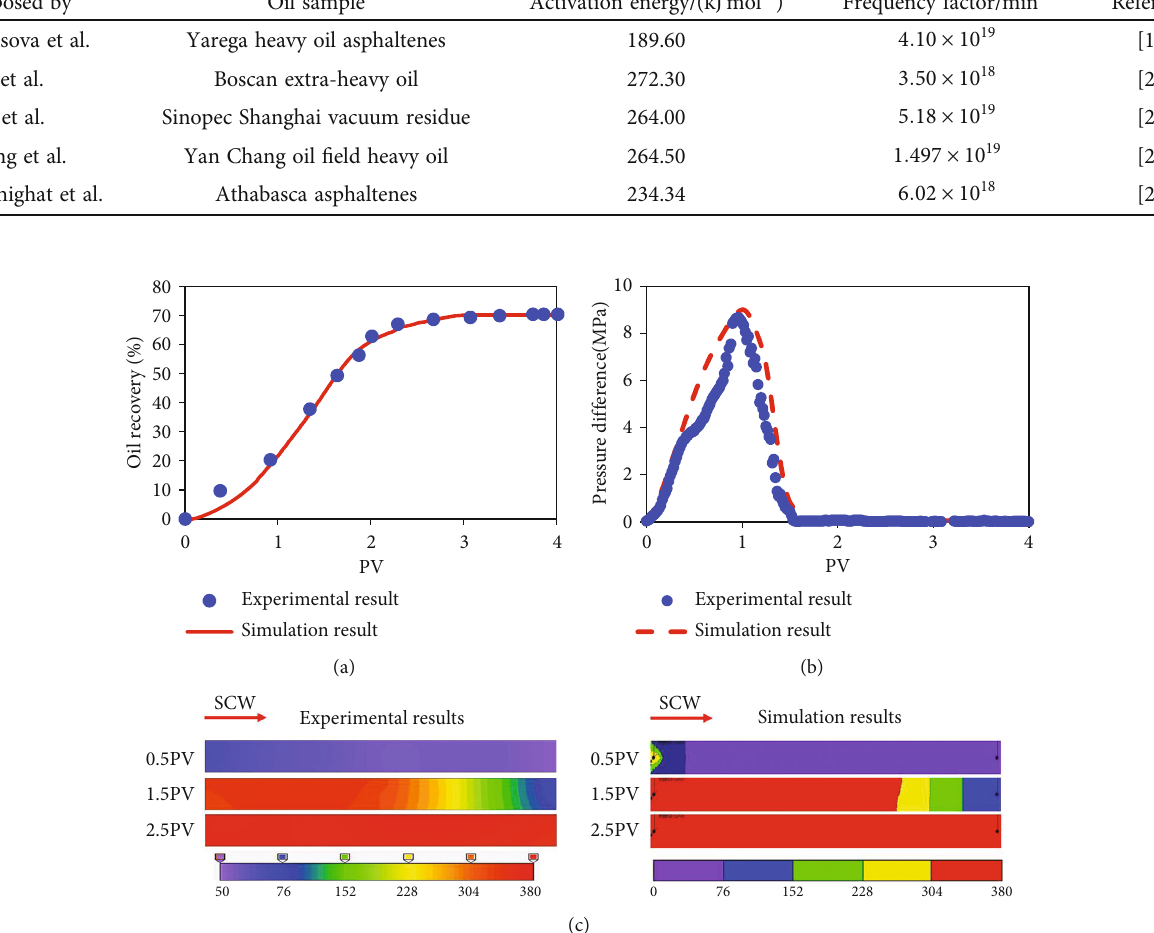
a 48 × 19 × 19 grid system (grid dimensions of 2 : 0 cm × 0 : 2 cm × 0 : 2 cm ) as shown in Figure 6.